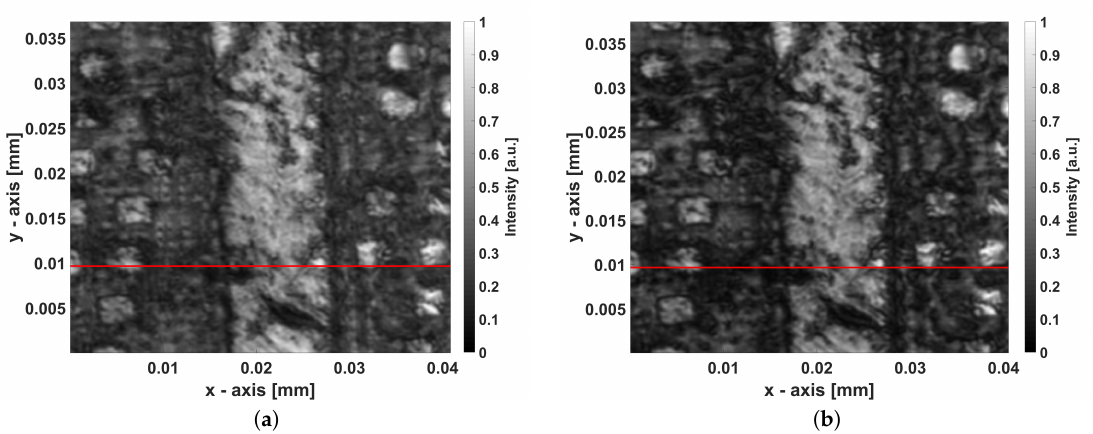
Figure 11. ( a ) In-focus image. ( b ) Image with PDM far using a 10 AU pinhole.